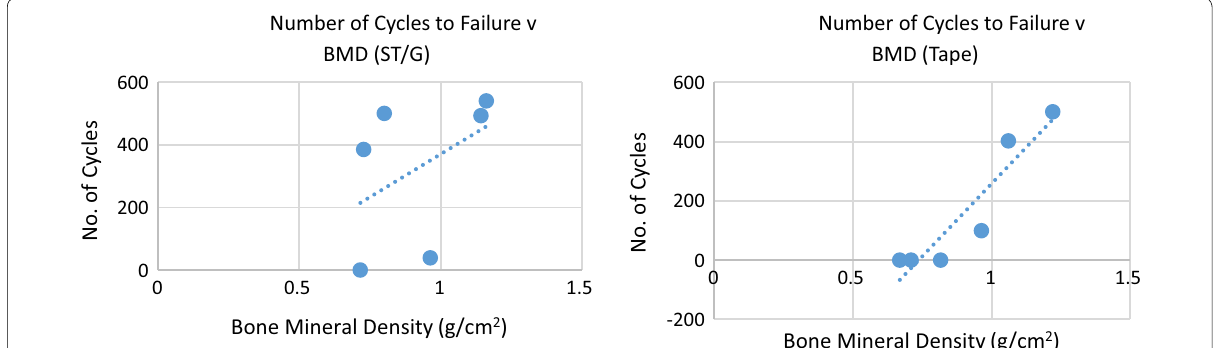
Fig. 10 Relationship between number of cycles to failure and bone mineral density for semitendinosus–gracilis and quadrupled semitendinosus tape constructs